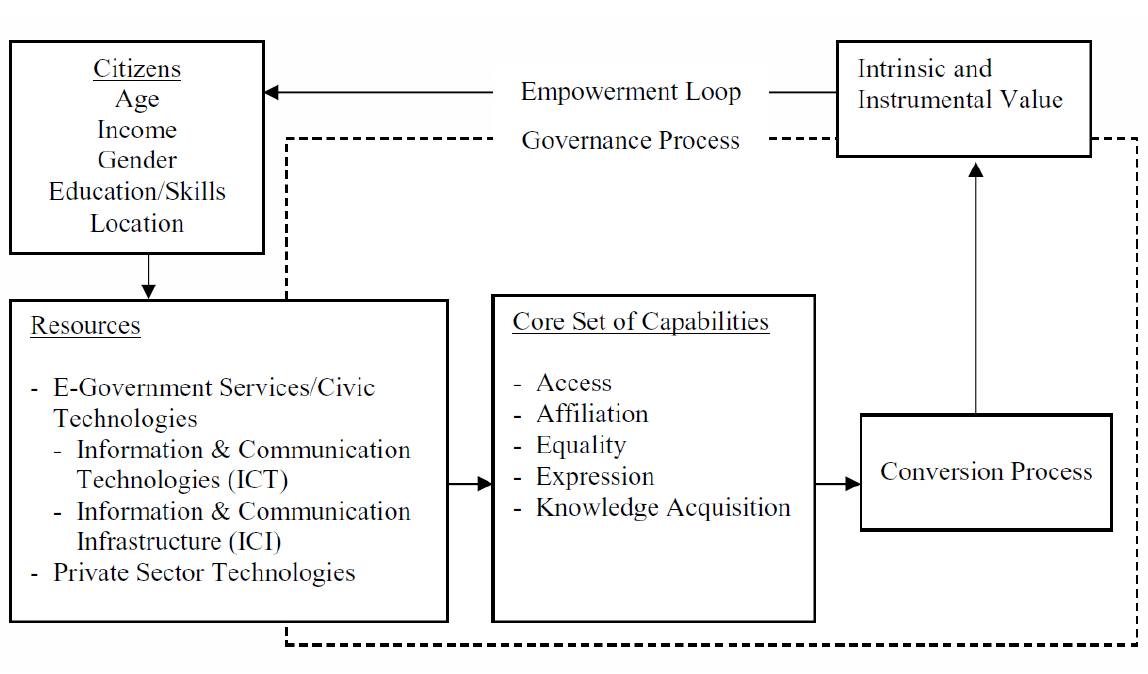
Figure 8: Capabilities Approach Framework for E-Participation (source: